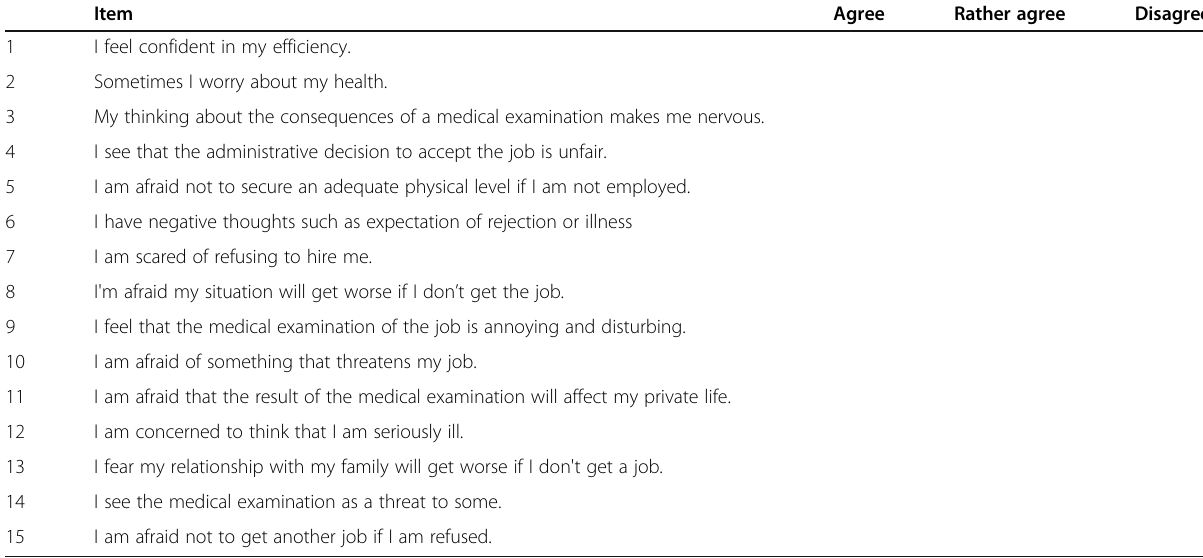
Table 2 Psychological stress